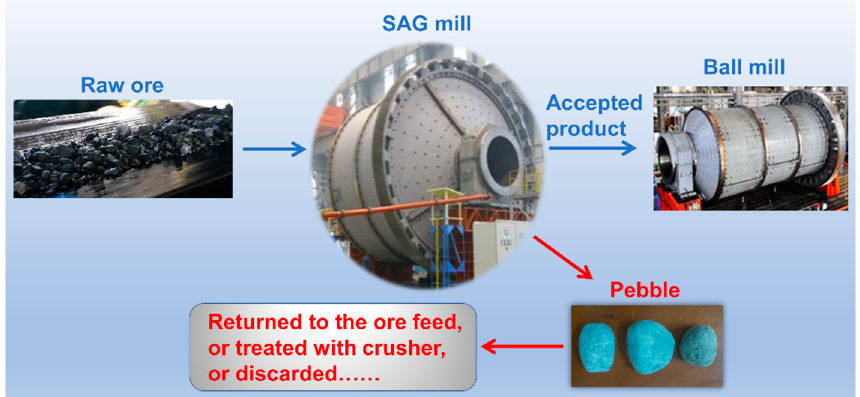
Figure 1. Schematic illustration of pebbles and the SAG process.